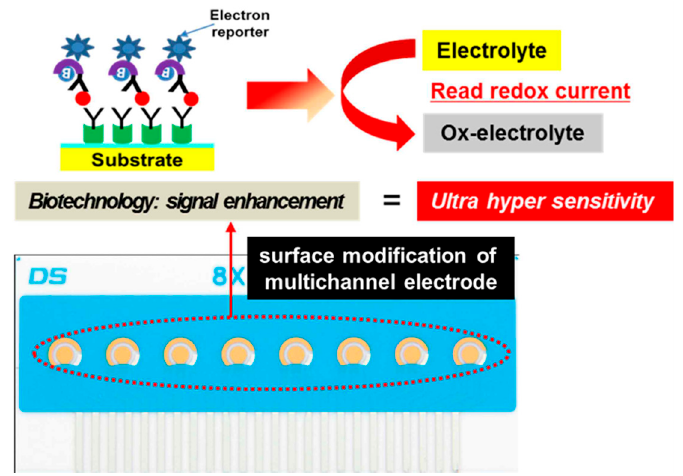
Figure 1. Electrochemical measurement of total IgE based on multichannel screen-printed